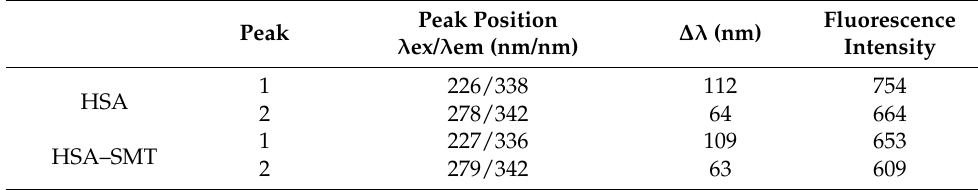
Figure 4. ( a ) 3D fluorescence spectra of HSA; ( b ) 3D fluorescence spectra of HSA – SMT. C HSA = C SMT = 3.3 × 10 −6 mol·L −1 . = 3.3 × 10 − 6 mol · L − 1 . Table 2. Characteristic parameters of 3D fluorescence spectra. Table 2. Characteristic parameters of 3D fluorescence